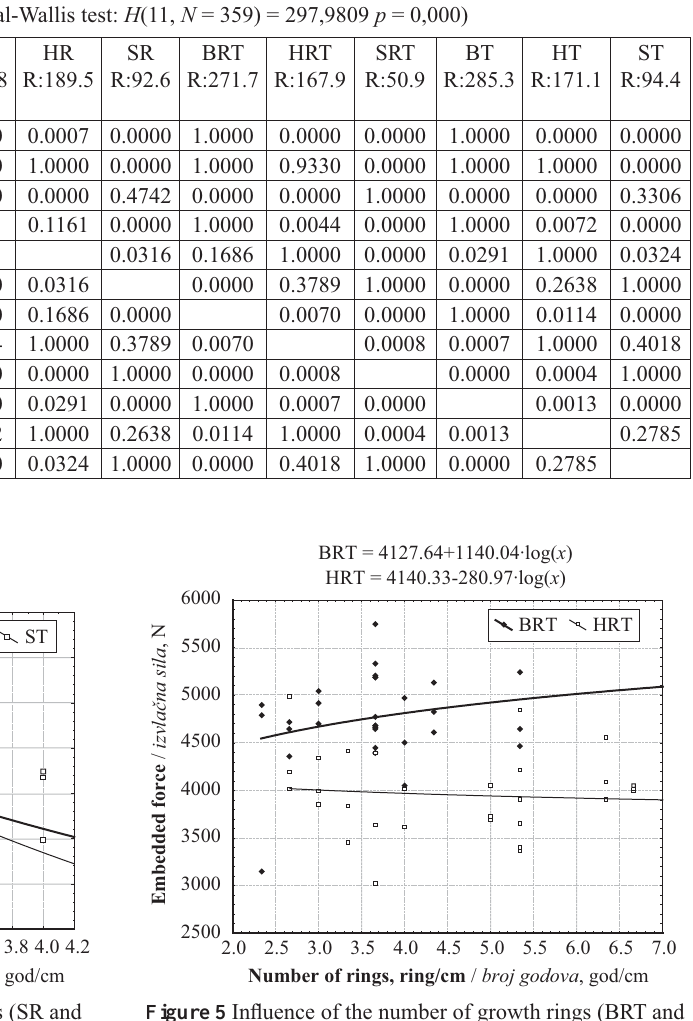
Figure 4 Infl uence of the number of growth rings (SR and ST) to embedded force